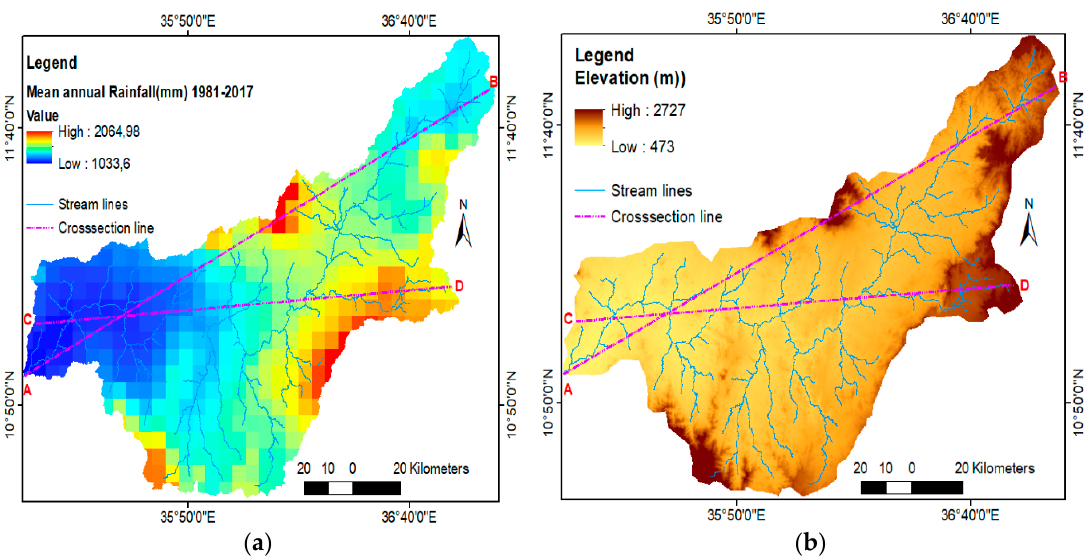
Figure 5. CHIRPS long-term mean annual rainfall (mm) from 1981 to 2017 ( a ) and Shuttle Radar Topography Mission (SRTM) 30 m Digital Elevation Model for Beles Basin ( b ).